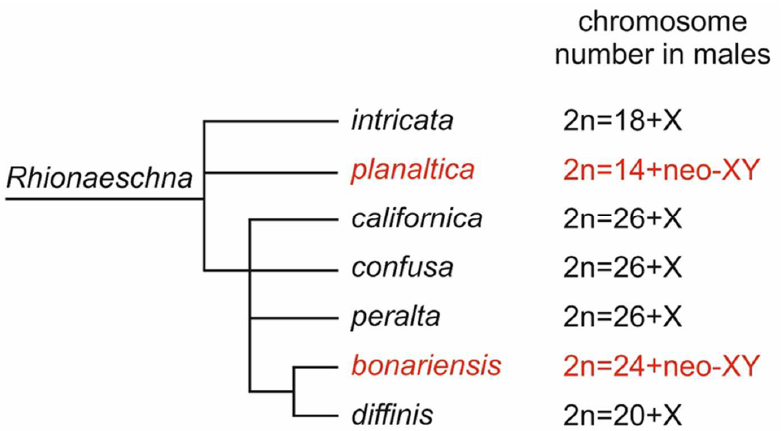
Figure 5. Simplified phylogenetic tree of Rhionaeschna species with known diploid chromosome number and sex chromosome constitution in males constructed according to the cladogram published in a previous study [33]. Species examined in this study are shown in red.